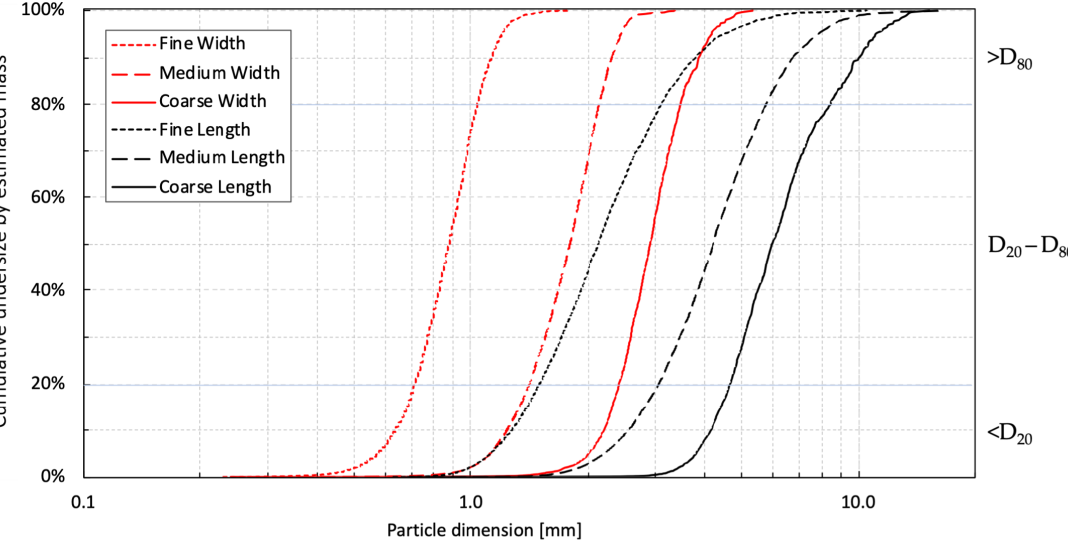
Figure 6. Estimated mass distribution per particle size category for particle width (red) and length (black) at logarithmic scale. Blue lines indicate D 20 and D 80 and mark the separation of each PSD into three distinct ranges (<D 20 ; D 20 – D 80 ; >D 80 ) for individual observation. Table 6. Properties of estimated mass particle size distributions (PSD) per range and granulometry.